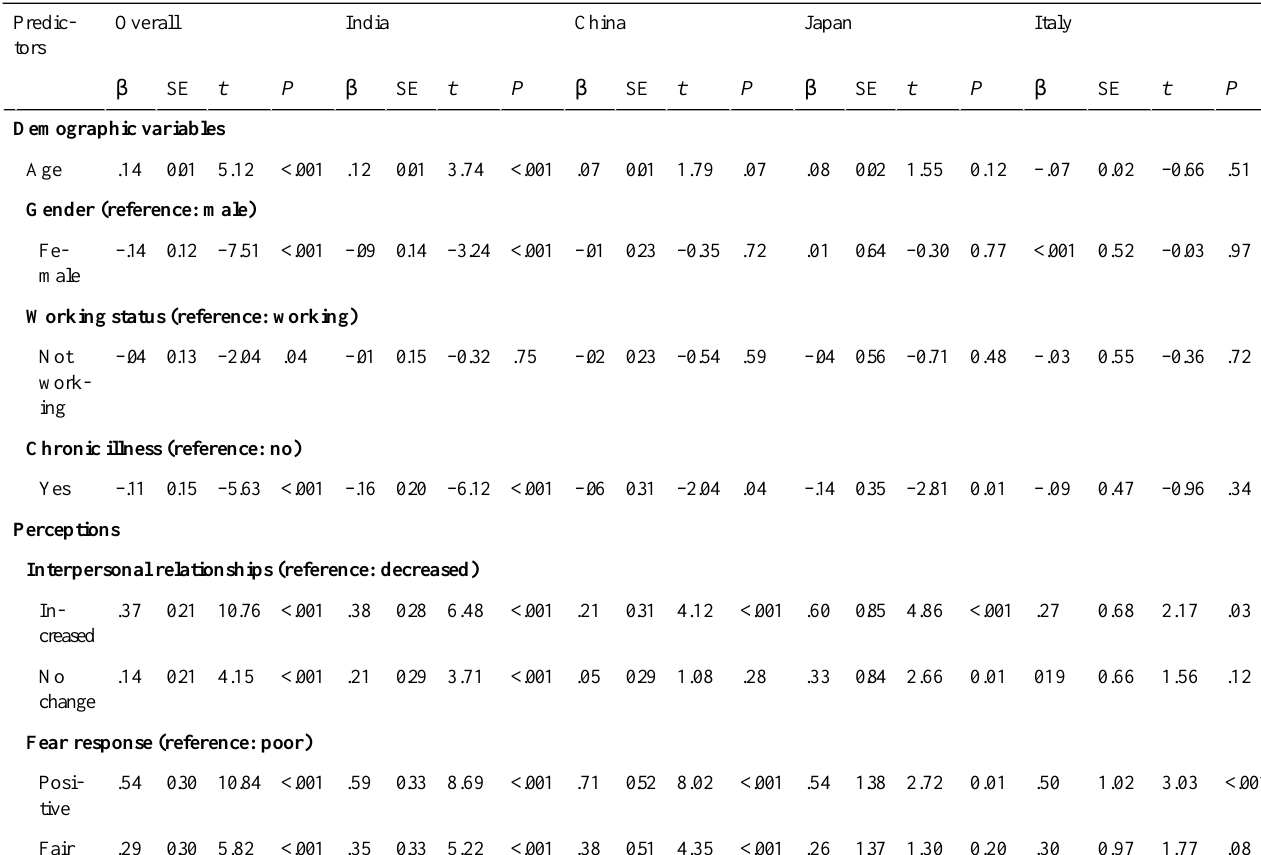
Table 3. Multivariate linear regression analysis ( β coefficients, standard errors, and t and P values) of the association between health status, personal variables, and